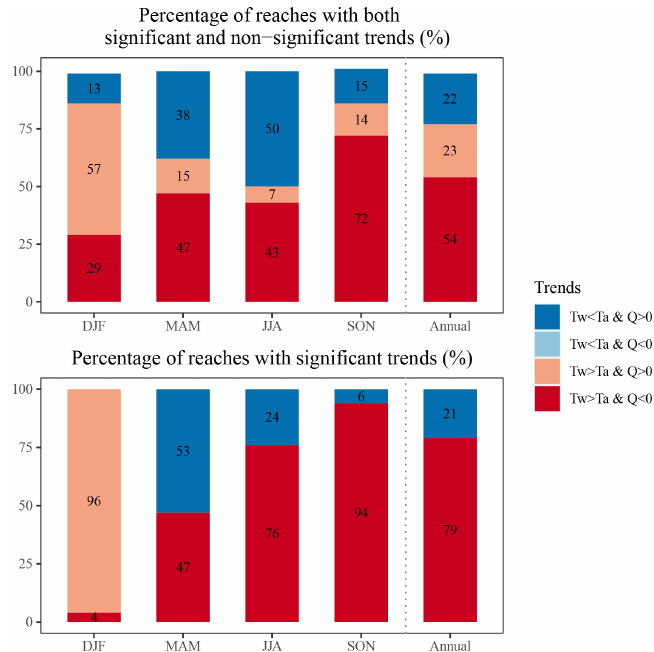
Figure 6. Percentage of reaches with consistent 1963–2019 trends in T w , T a , and Q , categorized with respect to two criteria: (1) comparison between the T w and T a trends and (2) sign of the Q trend. Sen’s slope is used as the trend value estimate.